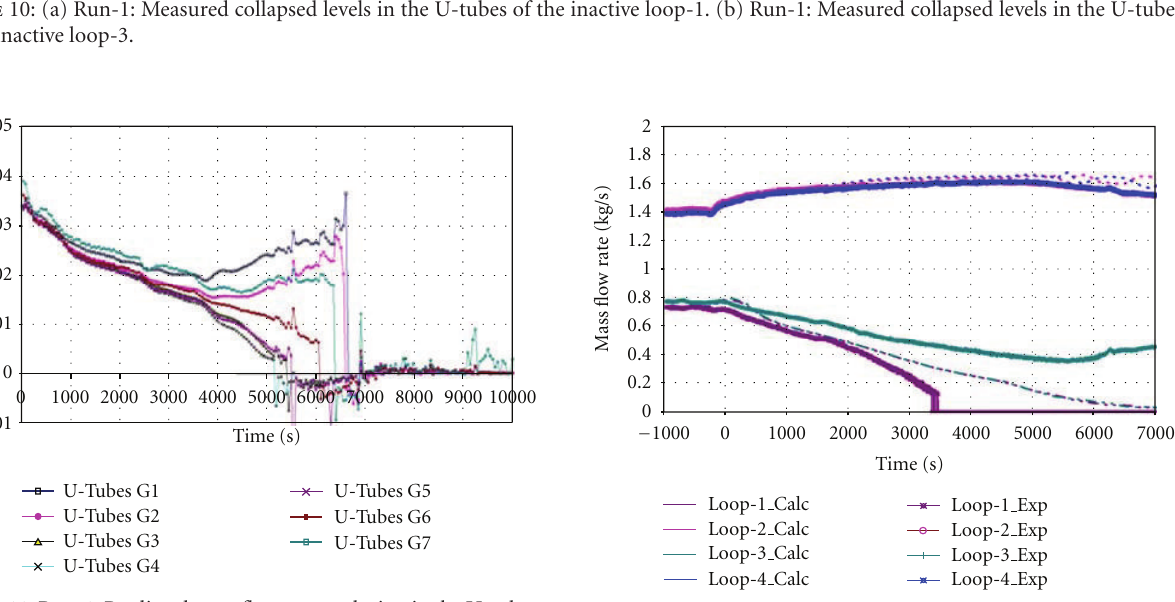
Figure 13: Run-2: Loops flow rate evolutions.